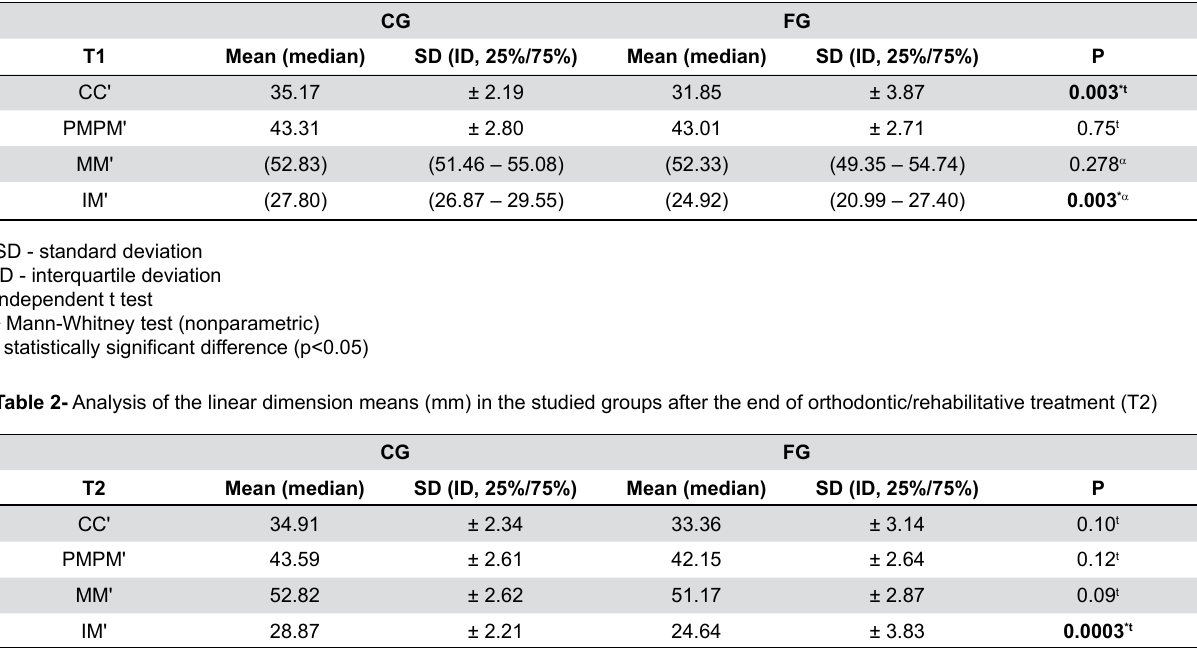
Figure 2- Definition and description of the Linear Measurements Table 1- Analysis of the linear dimension means (mm) in the studied groups after orthodontic finalization (T1)